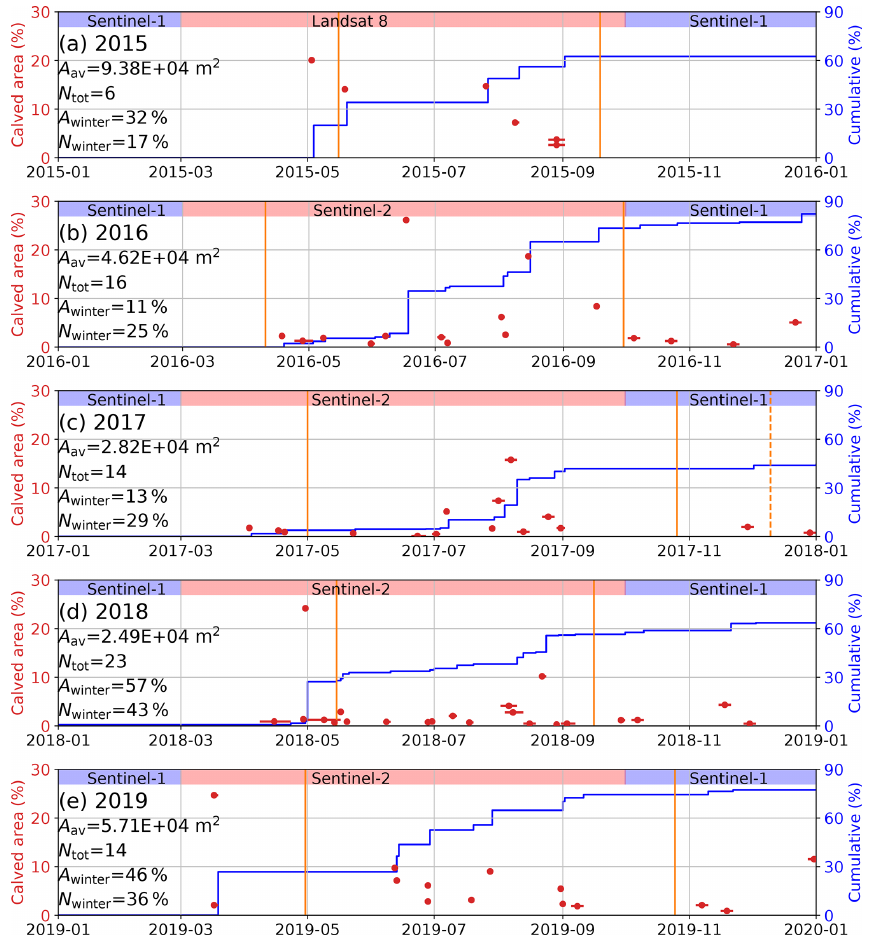
Figure 12. Time series of the area per calving event inferred from satellite image pairs (red, left y axis) and the cumulative annual area loss by calving (blue, right y axis), both relative to estimated annual discharge of 0 . 9km 2 . Horizontal red bars show when the date of calving is unknown. Vertical orange lines show the first and last 2 consecutive days with positive hourly temperatures. The dashed orange line in 2017 indicates a separate 2d peak with positive temperatures in December. The source of satellite imagery is indicated at the top of each panel. The average calved area per event ( A av ), number of events ( N tot ), and the relative contribution of calved area and number of events in winter ( A winter , N winter ) are given for each